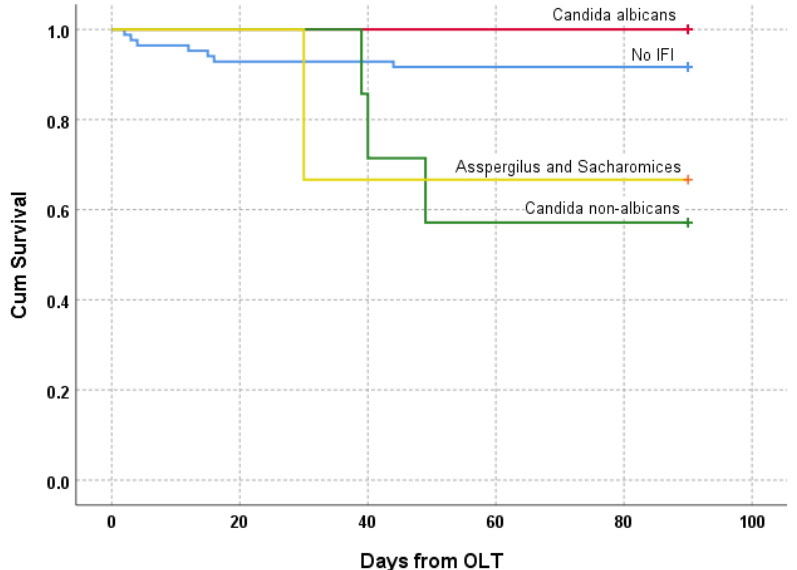
Figure 3. Kaplan – Meier curve: Mortality within 90 days depending on the cause of death. Abbrevi- Figure 3. Kaplan–Meier curve: Mortality within 90 days depending on the cause of death. Abbrevia- ations: OLT: orthotopic liver transplantation; IFI: invasive fungal infection. tions: OLT: orthotopic liver transplantation; IFI: invasive fungal